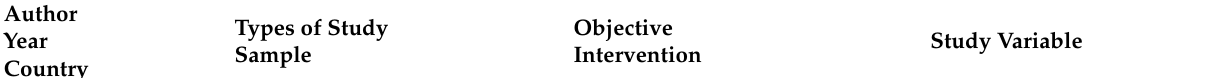
Table 2. General characteristics and main results of the included